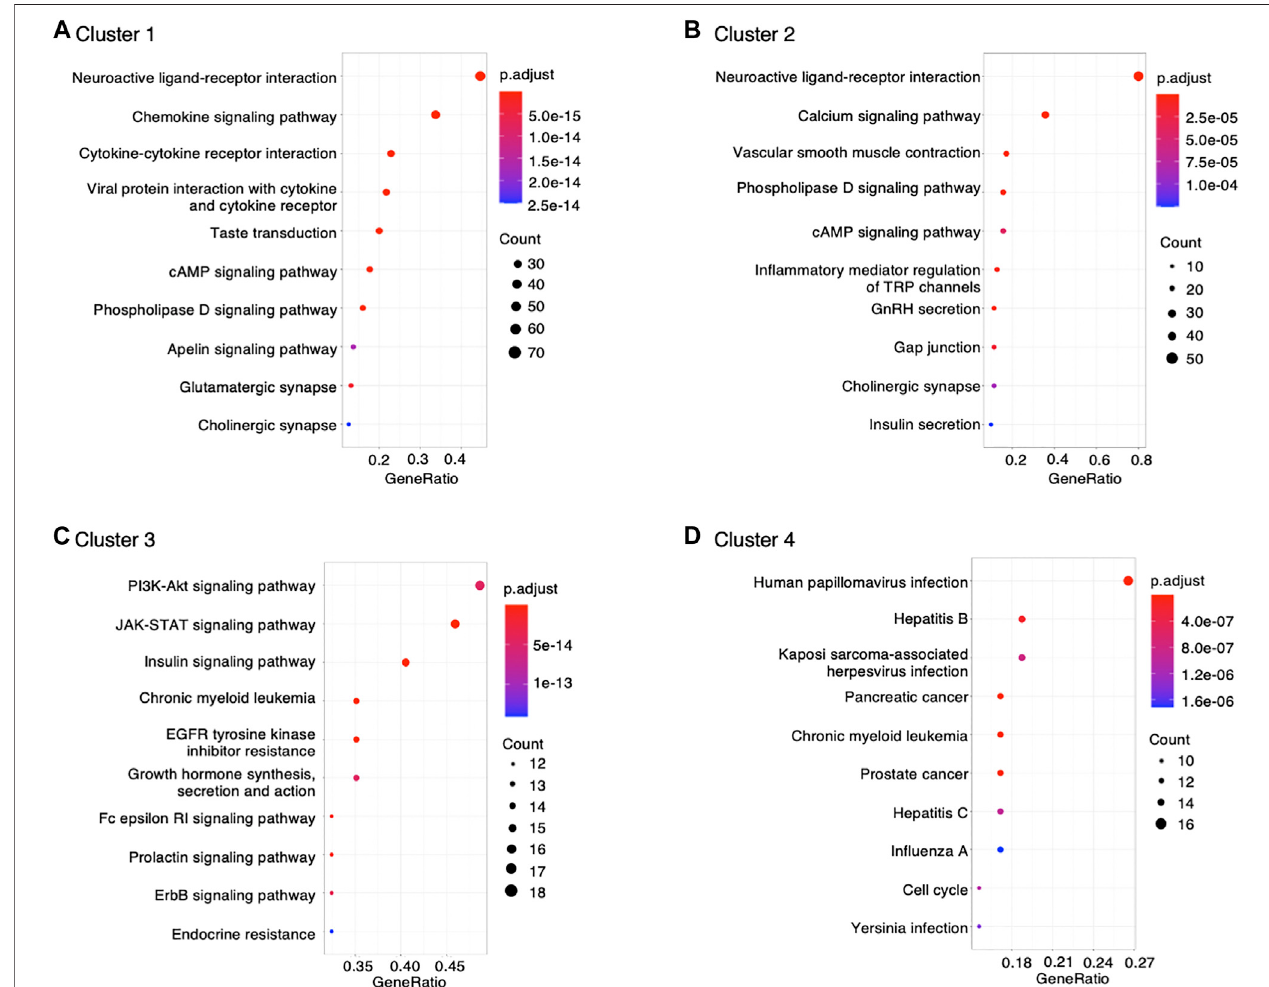
FIGURE 2 | Dot plot of KEGG functional enrichment